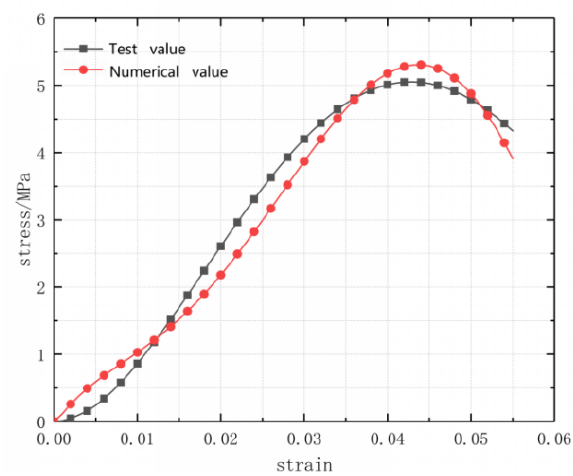
Figure 6: Analysis of parameters inversion